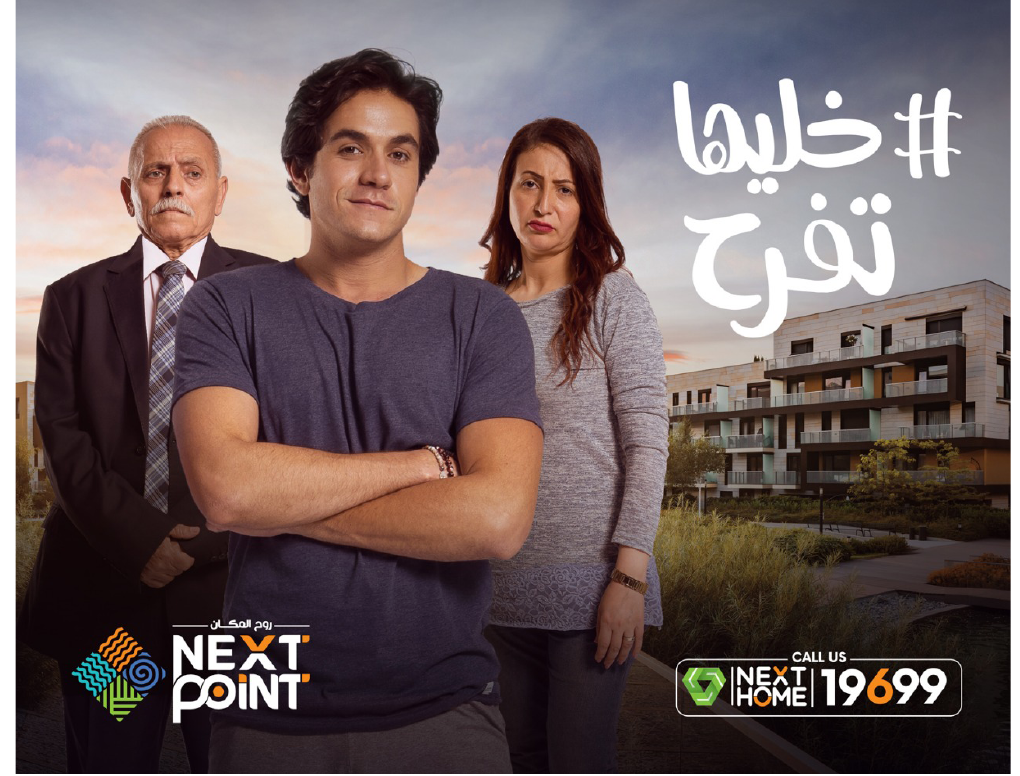
Figure 2. Photo from Cairo’s real estate street billboards (translation: Make her happy). Source: Next Home Egy (2019). caters beyond the reach of most